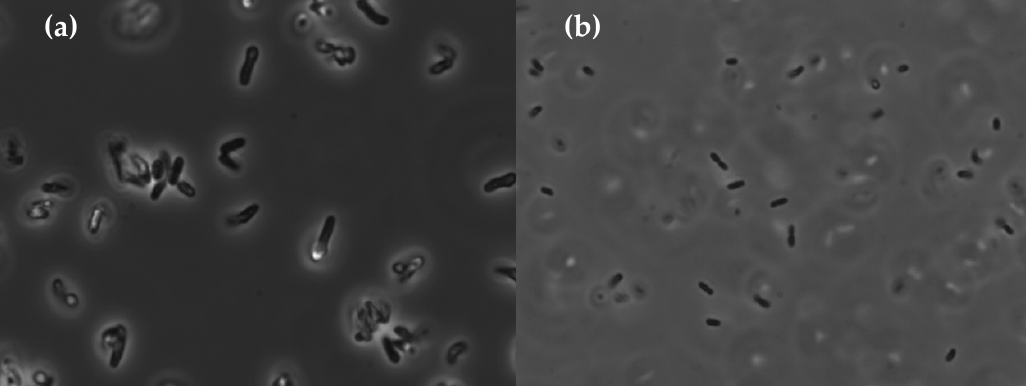
Figure 7. Epifluorescent microscope images revealing the rod-shape of ( a ) Rhodococcus rhodochrous , and ( b ) Ochrobactrum anthropi bacteria.